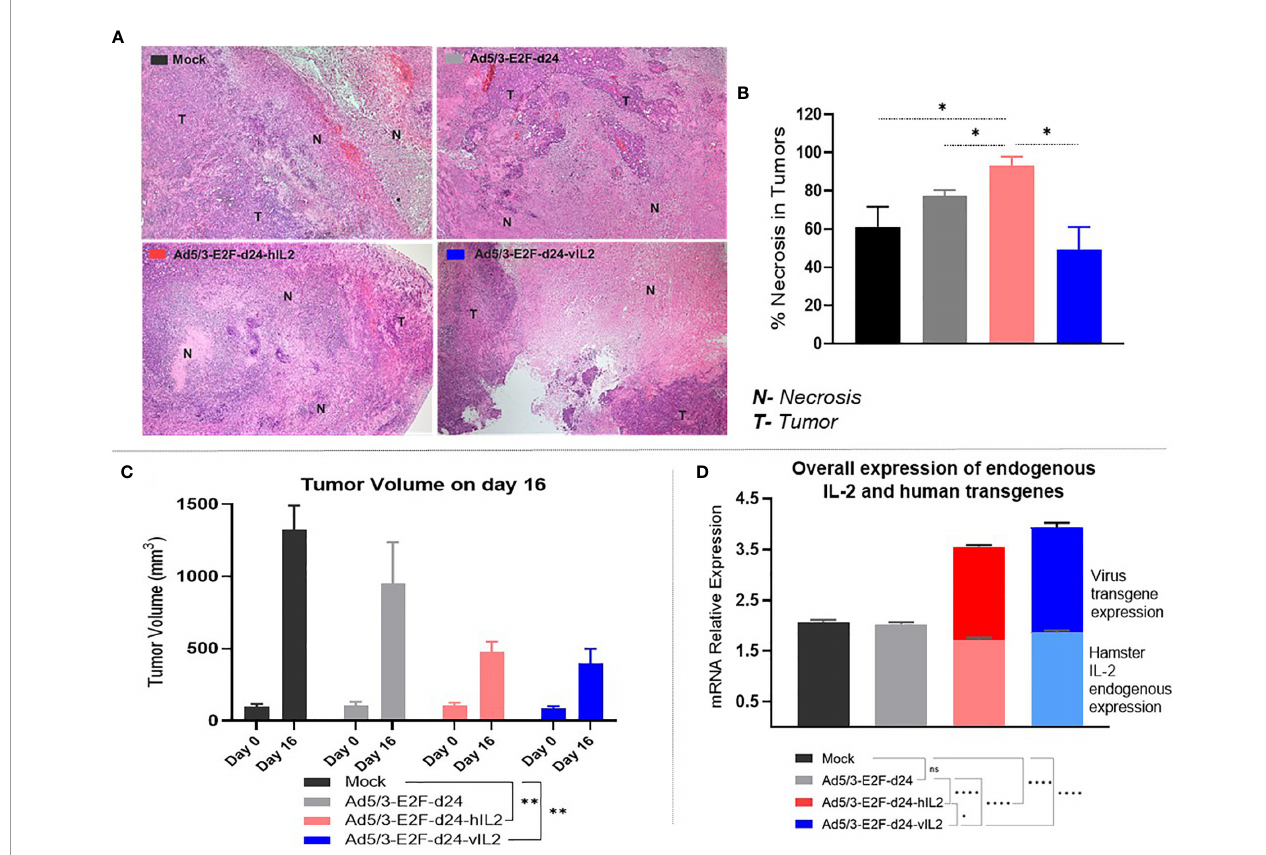
FIGURE 4 | View on tumor necrosis levels, anti-tumor response, and cytokine production in treated tumors. (A) Representative pictures of tumor tissues slides indicating necrotic (N) and tumor (T) areas in the experimental groups. (B) Percentage of necrosis levels identi fi ed across groups. (C) Tumor volume (mm 3 ) comparison on days 0 and 16. (D) Endogenous hamster wt IL-2 (bottom graphs) and virus delivered transgenes (upper graphs) relative mRNA expression. All data is presented as mean + SEM. *p < 0.05, **p < 0.01, and ****p < 0.0001. ns, not statistically signi fi